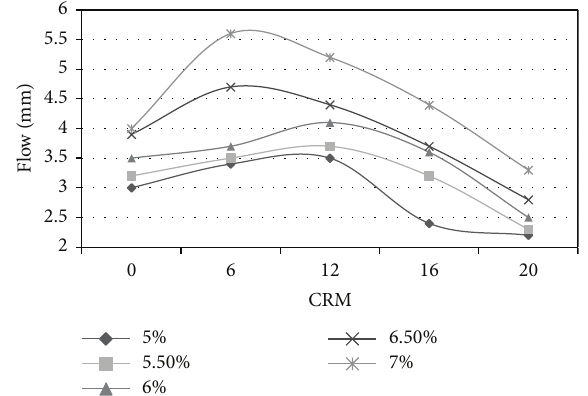
Figure 2: Stability results versus CRM content.